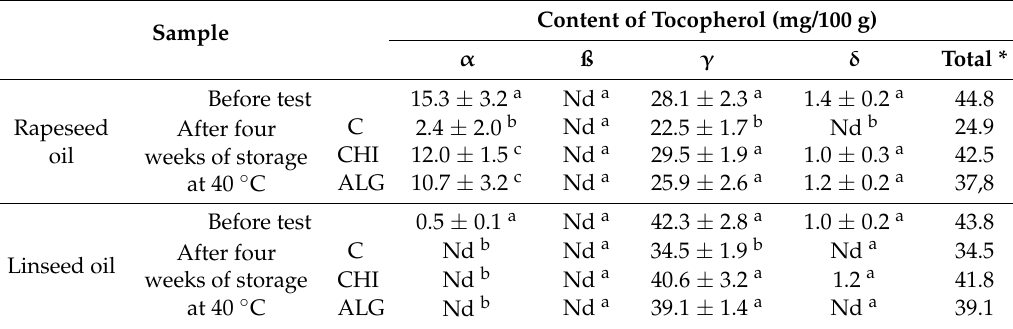
Table 7. Comparison of tocopherols content in rapeseed and linseed